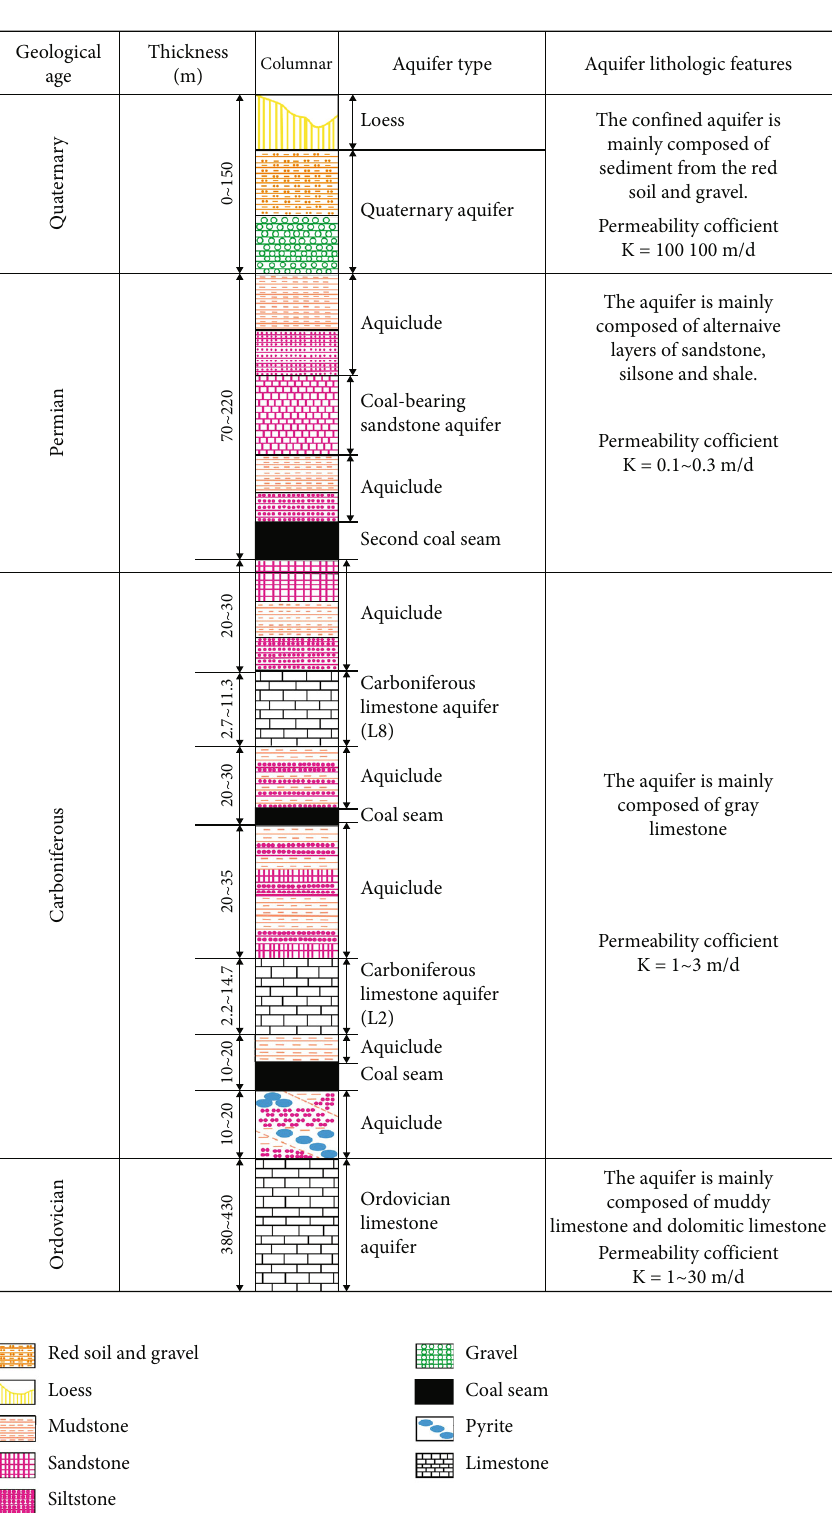
Figure 2: Stratigraphic histogram of the upper